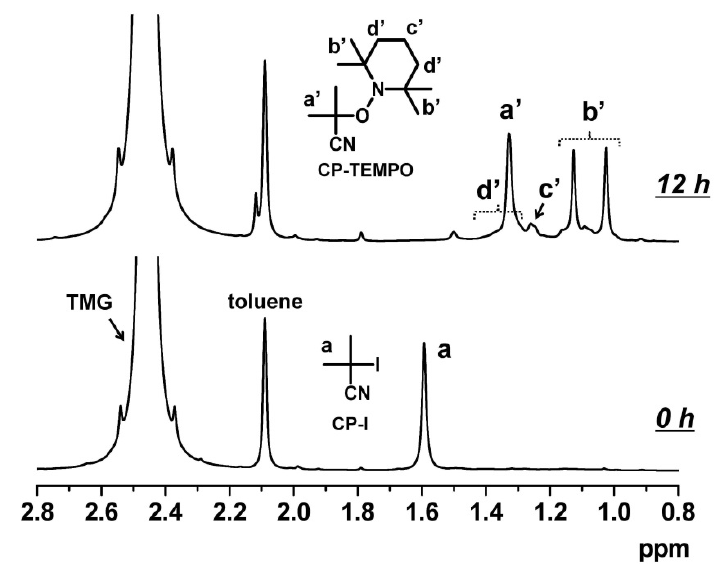
heated at 70 °C for 0 and 12 8